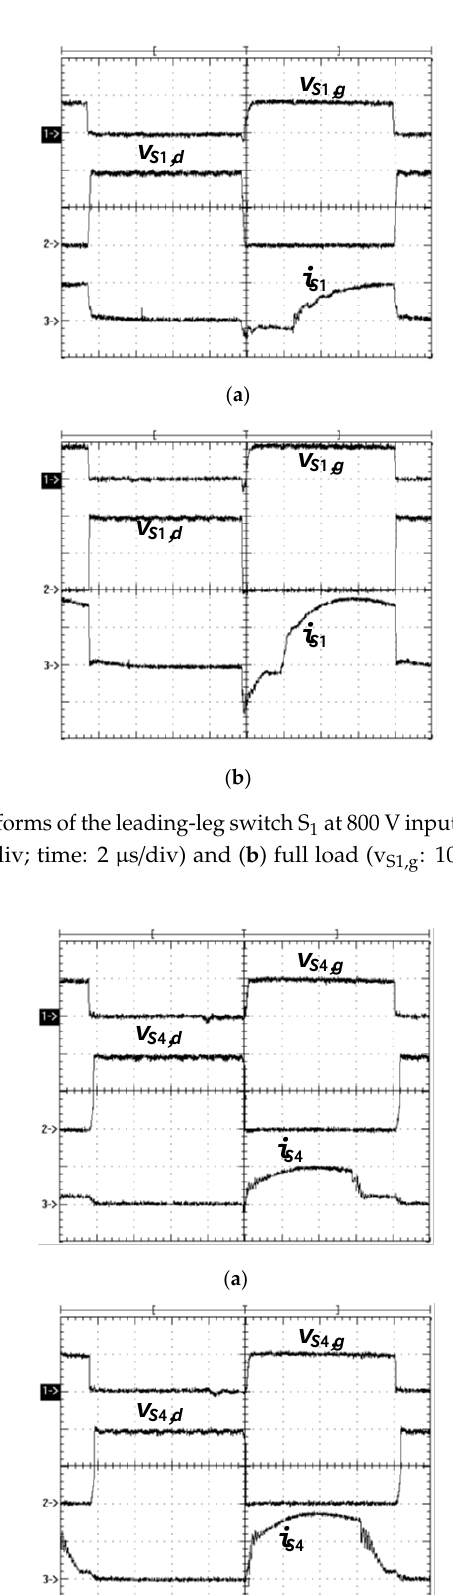
Figure 11. Measured waveforms of the secondary-side currents i Lo1 , i Db1 , i o1 and i o2 ( a ) 20% load (i Lo1 , i Db1 : 5 A/div; i o1 , i o2 : 10 A/div; time: 4 s/div) and ( b ) full load (i Lo1 , i Db1 , i o1 , i o2 : 20 A/div; time: 4 s/div).